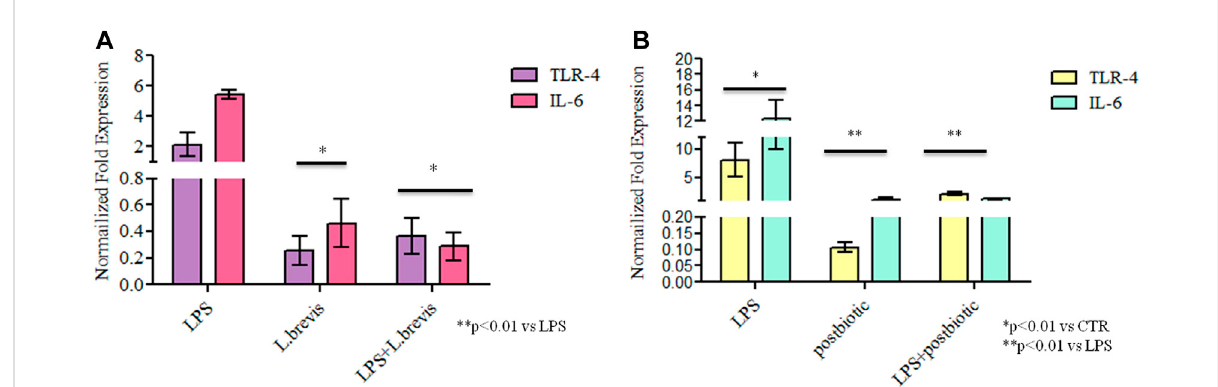
FIGURE 5 Gene expression analyses: results are expressed as fold change of (A) LPS, L. brevis alone and LPS + L. brevis and (B) LPS, postbiotic, and LPS + postbiotic treated cells in respect to untreated cells (CTR) for TLR-4 and IL-6 in human enterocytes. RNA was extracted from two different wells treated with the same batch of samples. Data are shown as average ±SD. Student t-test was used for the evaluation of statistical differences and signi fi cance was indicated as * p < 0.01 vs CTR, ** p < 0.01 vs